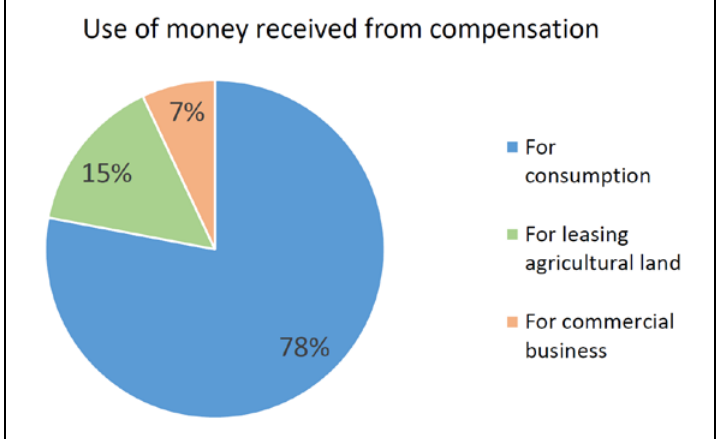
Figure 2. Distribution of sample households by their use of the—compensation money. Source: Household survey, n = 100, 2020.